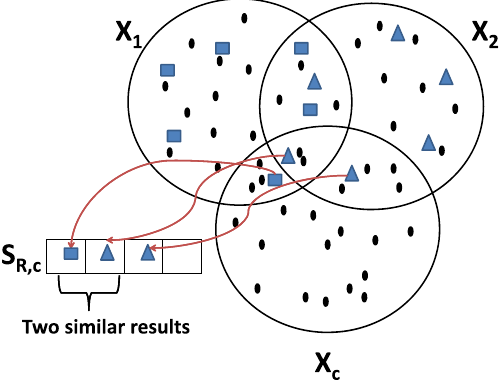
Fig. 5 Scaling hypothesis diversity function for different queries Fig. 6 Reusable Set S